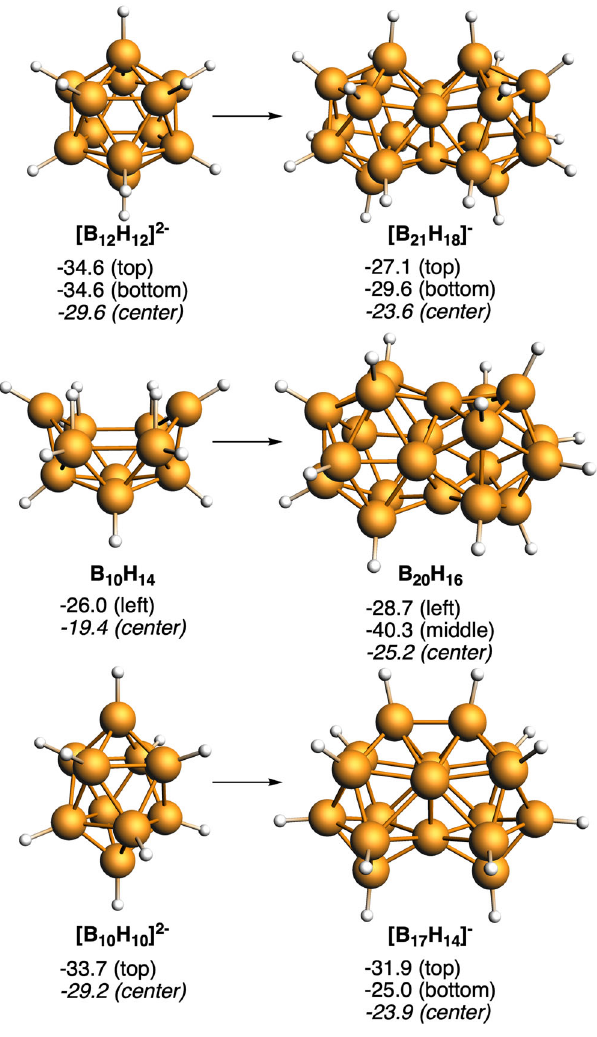
Fig. 2 3D/3D systems formed from [B 12 H 12 ] 2 − , B 10 H 14 , and [B 10 H 10 ] 2 − . Computed NICS (in ppm) at the center of different fi ve- and four- membered rings and at the center of each cluster are enclosed. Boron atoms in orange and H atoms in white.